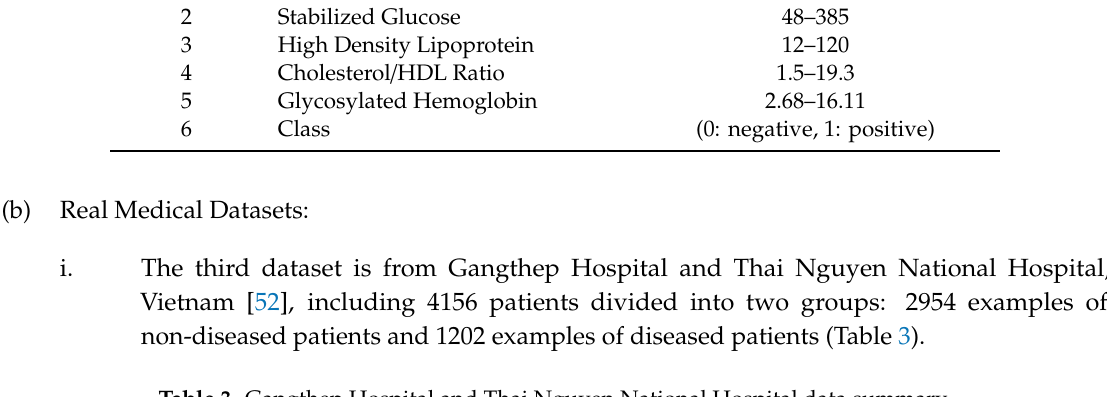
Table 3. Gangthep Hospital and Thai Nguyen National Hospital data